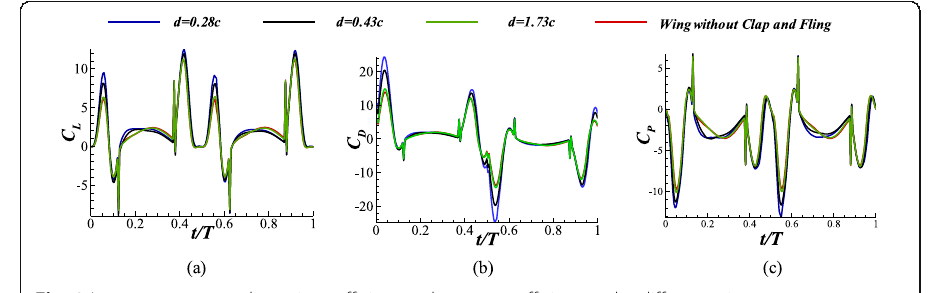
Fig. 8 Instantaneous aerodynamic coefficient and power coefficient under different wing